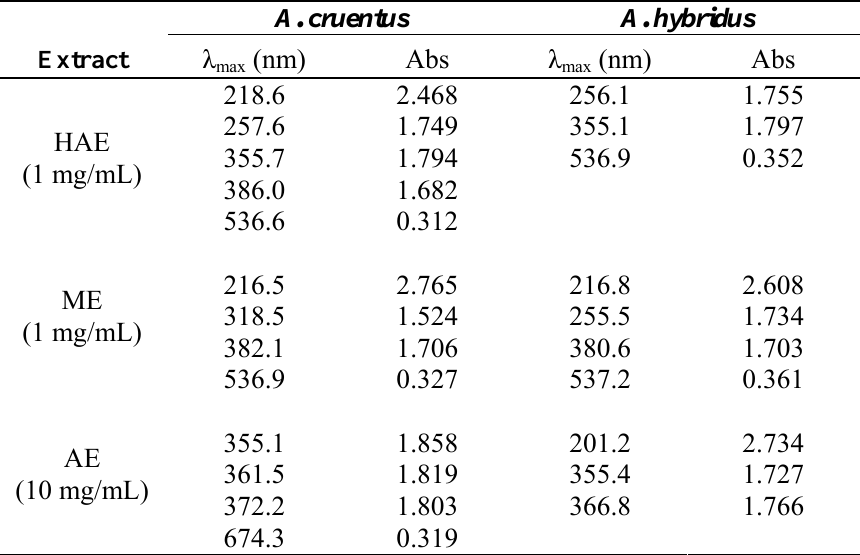
Table 3. UV-VIS absorption peaks of A. cruentus and A. hybridus.